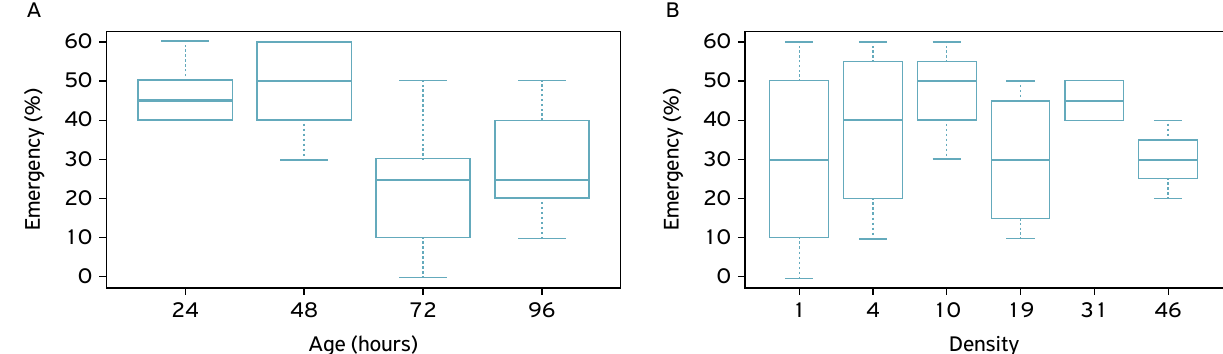
Figure 2. Emergence (%) of Palmistichus elaeisis (Hymenoptera: Eulophidae) at (A) different host ages and (B) different parasitoid densities (25 ± 2°C, 60 to 80% 70 ± 10% relative humidity and 12 hours